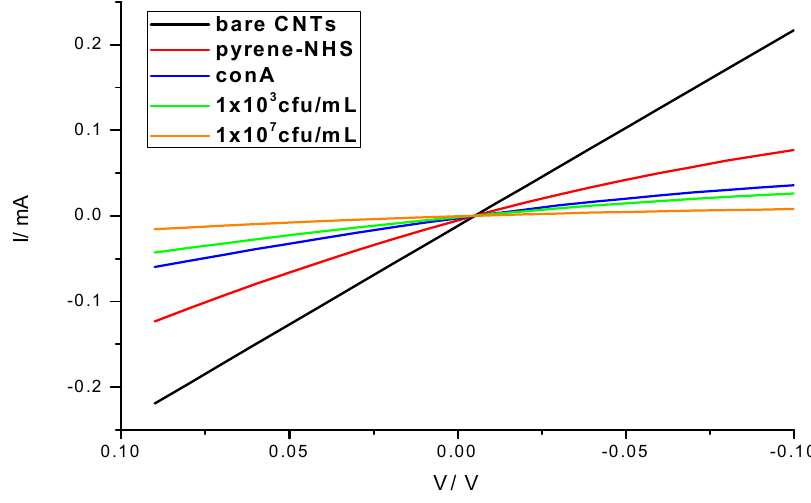
Figure 3. I-V characteristics of the biosensor showing the progression of the device fabrication, surface functionalization and E. coli bacteria detection (1 × 10 3 and 1 × 10 7 cfu/mL).